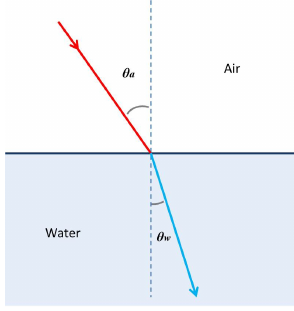
Figure 2. Study area: the Aono Research Forest, the Arboricultural Research Institute of the University of Tokyo Forests, Izu Peninsula in Japan (ALOS AVNIR2, acquired on August 8, 2009). A triangle shows the location of TLS measurement. rate is maximum 50,000 points per second with minimum point spacing of 5 mm. Multiple measurements were conducted by positioning TLS at several different locations along the channel, so that all data were collected within short ranges (< 5m). In order to identify the water surface in the point cloud later in the laboratory, planar objects of foamed styrol were floated in the channel. Underwater data was water refraction corrected using the method of Smith et al. (2012), which utilizes Leica ScanStation to measure submerged gravel beds. Figure 3 shows the point cloud before and after the correction. One brick (Small: 10 cm x 10 cm x 6 cm) and cement block (Large: 10 cm x 20 cm x 6 cm), which were colour taped at different surfaces for better recognition of the edges, were sunken in each plot.